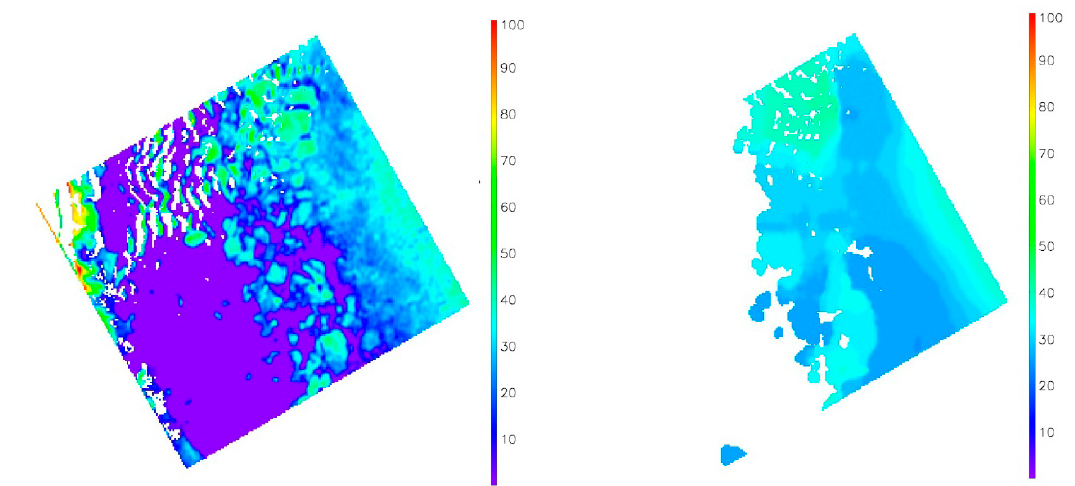
Figure 4. ( left ) Reflectance at 0.67 μ m from S-NPP VIIRS; and ( right ) derived tie points at 0.67 μ m.